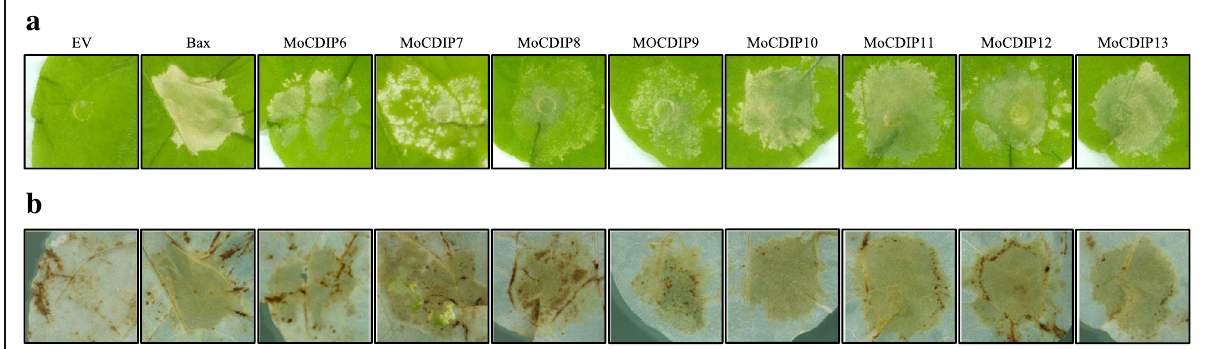
Fig. 1 Identification of eight novel M. oryzae cell death-inducing proteins (MoCDIPs). a Transient expression assay of 98 M. oryzae putative secreted proteins revealed that eight of them induced cell death in N. benthamiana leaves. EV, an empty vector pGD. b Transient expression of the eight M. oryze cell death-inducing proteins induced H 2 O 2 accumulations in N. benthamiana leaves as shown by 3,3 ′ -Diaminobenzidine tetrachloride (DAB) staining. The leaves were photographed 5days after infiltration. The agroinfiltration experiments were repeated at least three times